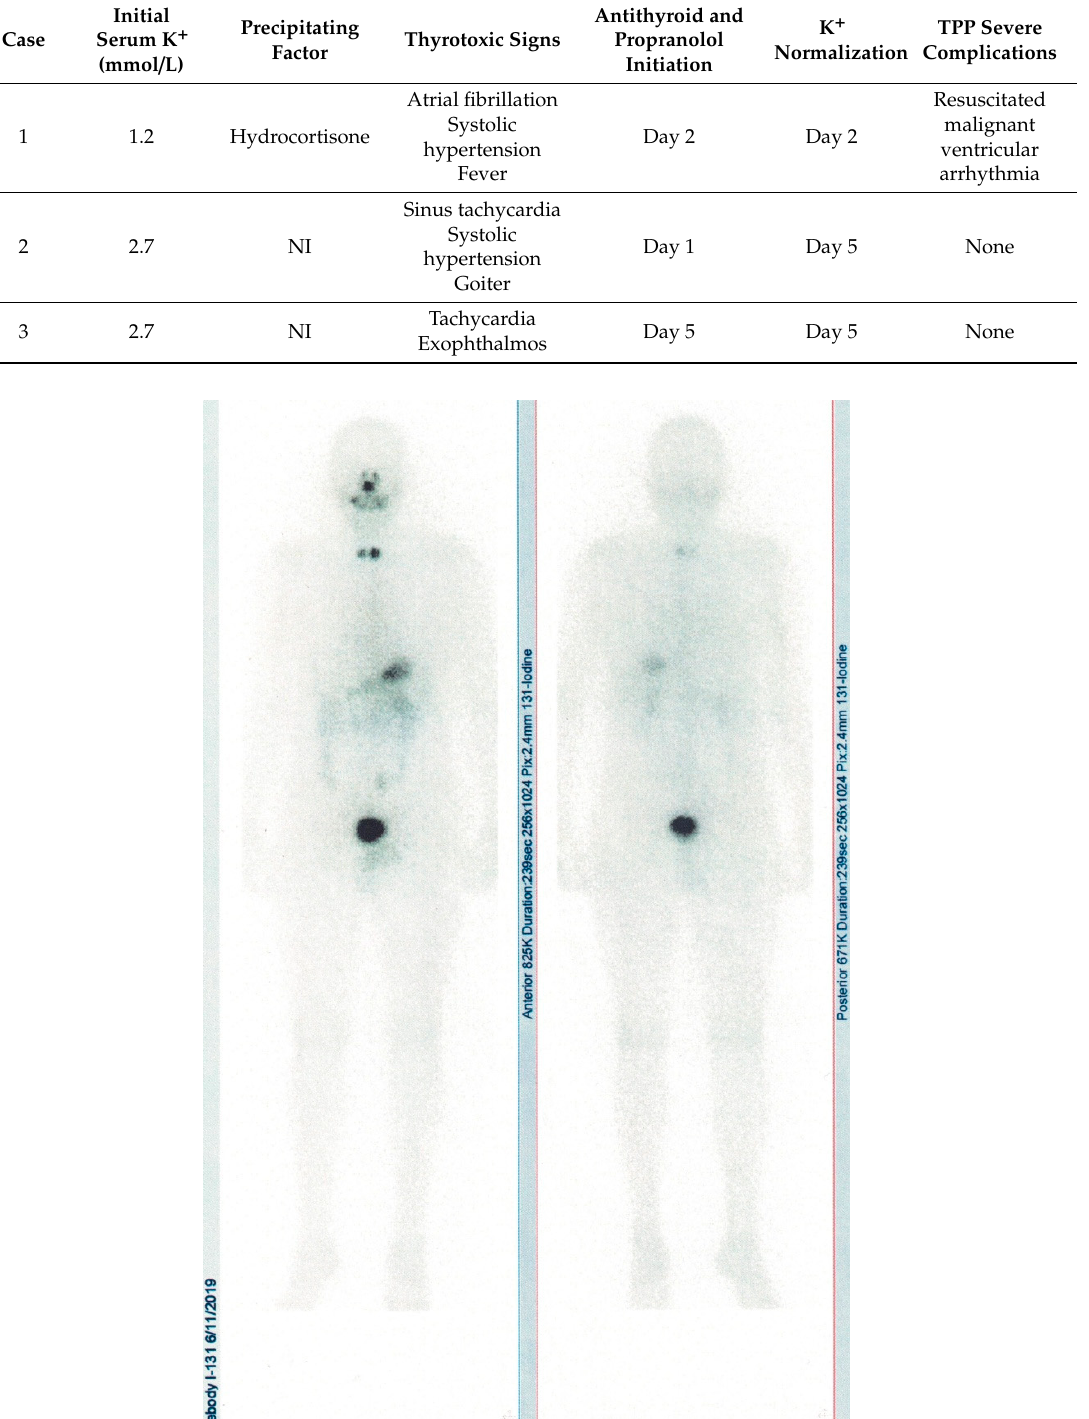
Table 1. Summary of TPP evolution in the presented patients. NI = not identified, TPP = thyrotoxic periodic paralysis.